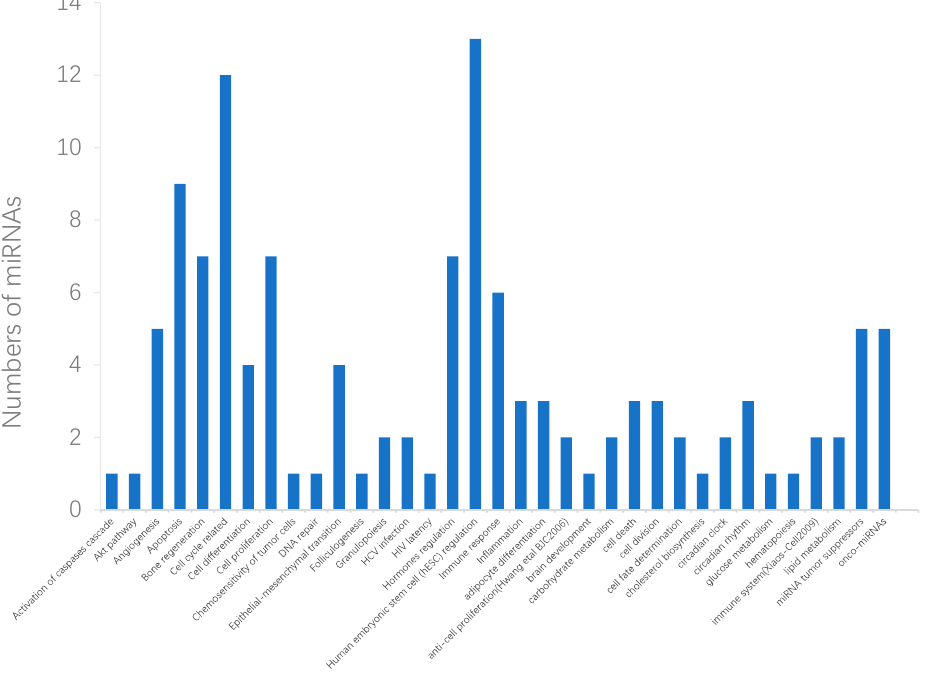
Figure 3. Functional enrichment analysis of lung cancer-related miRNAs. The horizontal ordinates represent 35 significant enriched functions of the top 50 candidate miRNAs associated with lung neoplasms. The vertical coordinates represent the number of miRNAs associated with each enriched function.